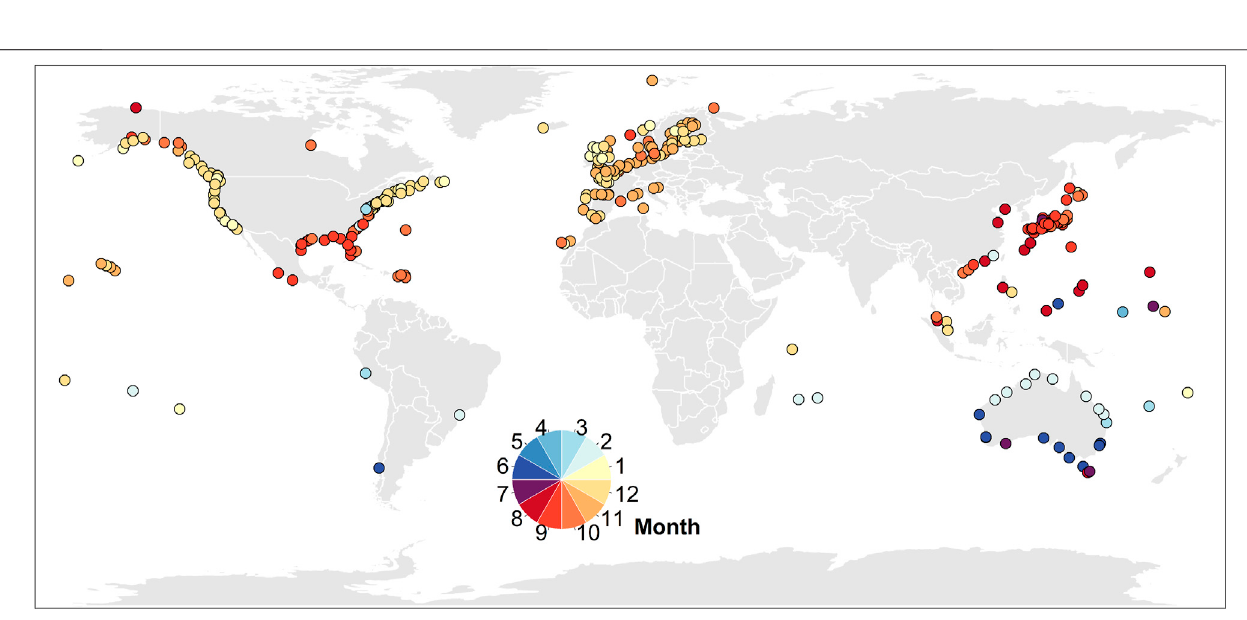
Frontiers in Earth Science |